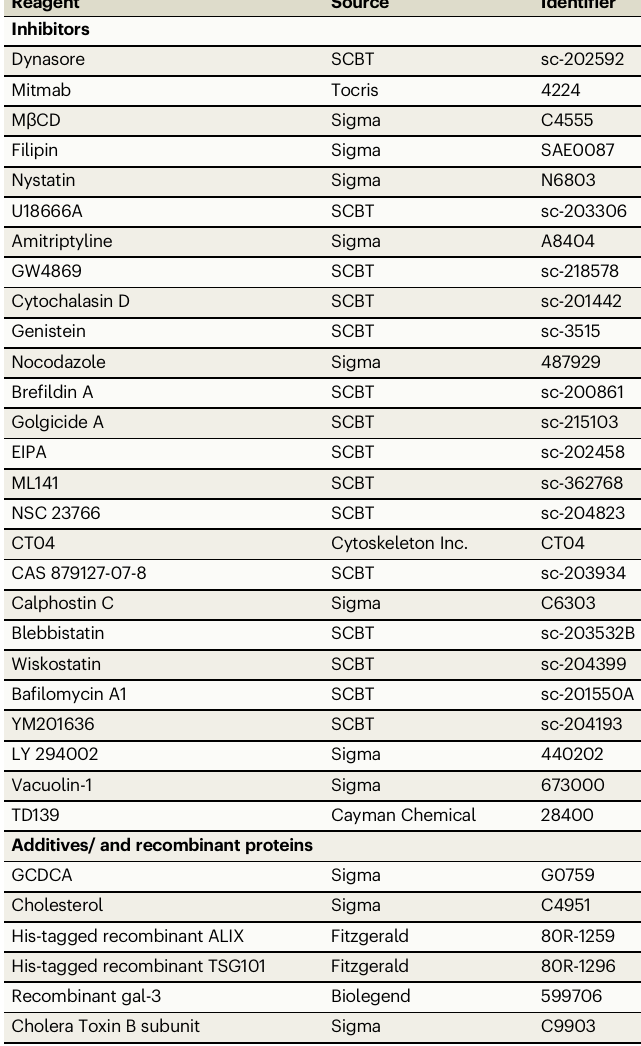
Table 2 | List of inhibitors, additives and recombinant